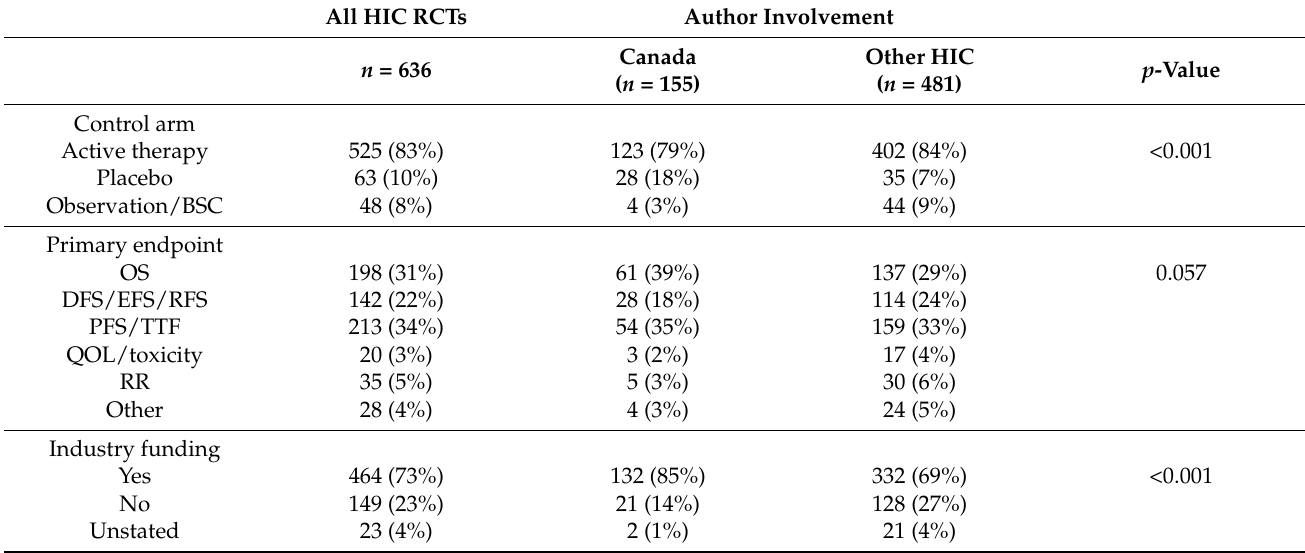
1 Column total does not add to 636 due to missing data, or due to rounding. 2 Combined experimental arms include systemic-RT ( n = 22), systemic-surgical ( n = 3), surgery-radiation ( n = 1), 3 Other experimental interventions included hyperthermia plus RT ( n = 2), photodynamic therapy, stem cell transplant, tumor treating field ( n = 1 each).